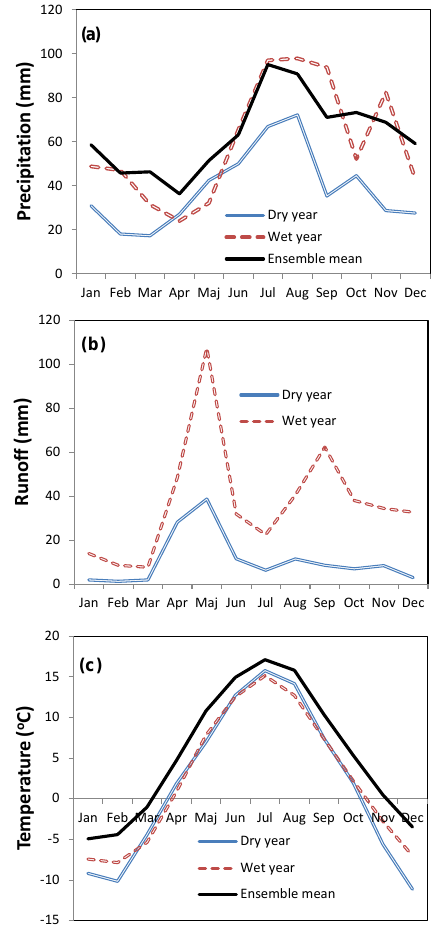
Figure 3. Seasonal patterns of (a) present-day precipitation in dry and wet years vs. the ensemble mean (bias-corrected) of future pre- cipitation projections, (b) present-day runoff dynamics in dry and wet years and (c) present-day temperature in dry and wet years rel- ative to the ensemble mean (bias-corrected) of future temperature projections. Note that the dry and wet years in these plots represent the average of all the individual dry and wet years,